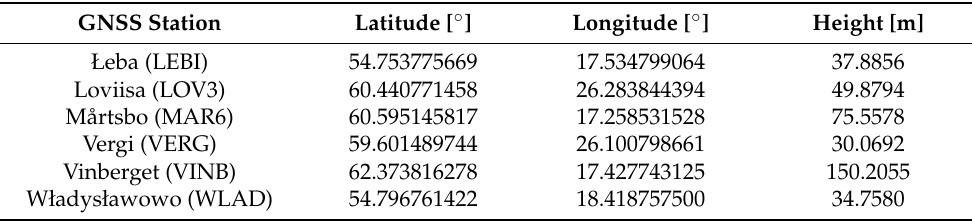
Table 6. GNSS stations geodetic coordinates (latitude, longitude, and height) in ITRF2014 epoch 2020.50 (from period 1 January 2020 to 31 December 2020) referred to GRS-80 ellipsoid. Solution from DD method. Only GNSS stations coordinates immediately co-located to an ECR stations are shown. GNSS Station Latitude [ ◦ ] Longitude [ ◦ ] Height [m] Łeba (LEBI) 54.753775669